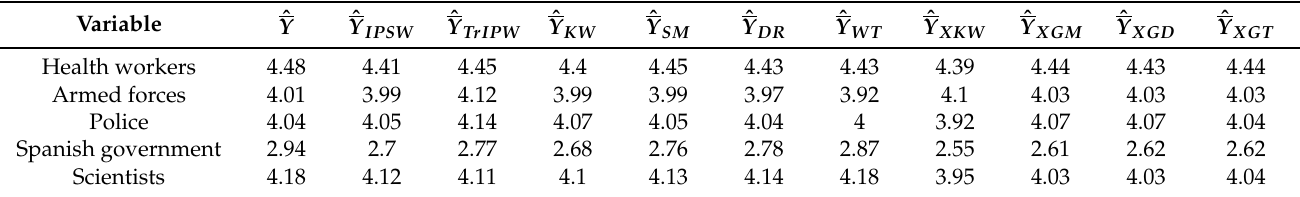
Table 7. Estimates of the population means of the variables measuring the rating (1–5) of the confidence in different groups/institutions to manage the current health crisis.